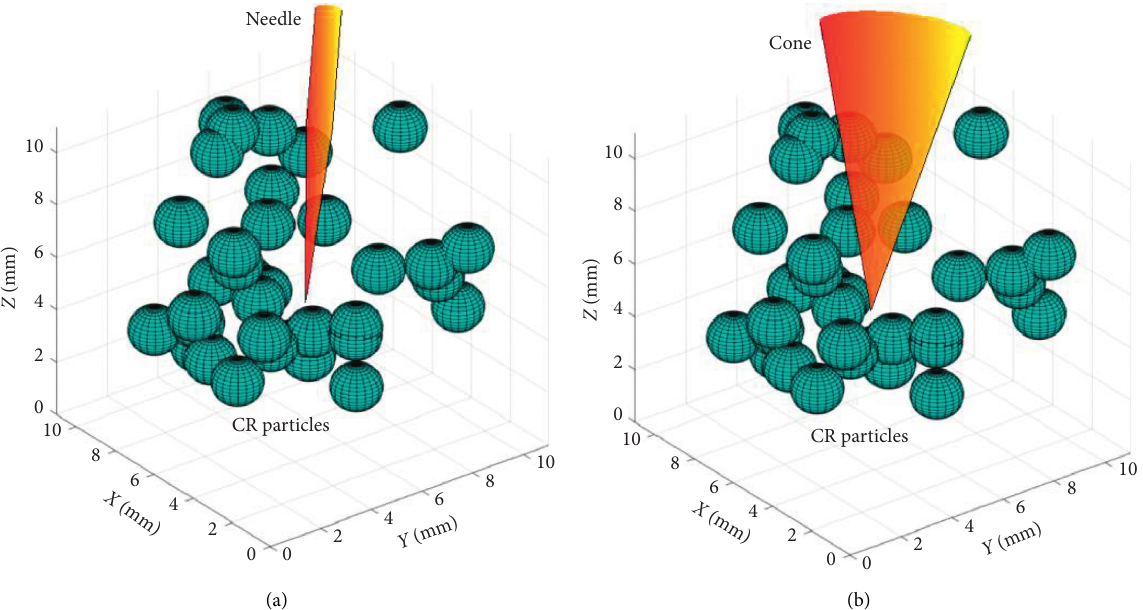
Figure 11: Experimental penetration process. (a) Needle penetration process. (b) Cone penetration process.